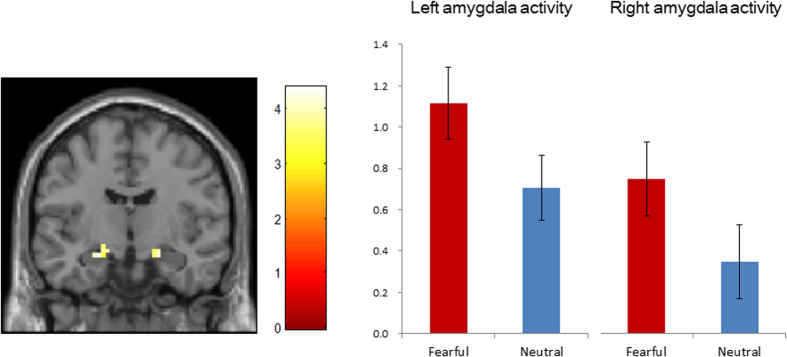
Increased activity of the bilateral amygdala upon the appearance of fearful faces vs. neutral faces outside the focus of attention.MNI coordinate: ±21 −10 −17. Significant at FWE-corrected p < 0.05 with small volume correction (SVC) for the left side, and at p < 0.001 with SVC for the right side. Colour bar indicates T-value. The coronal plane image is presented at y = −10.